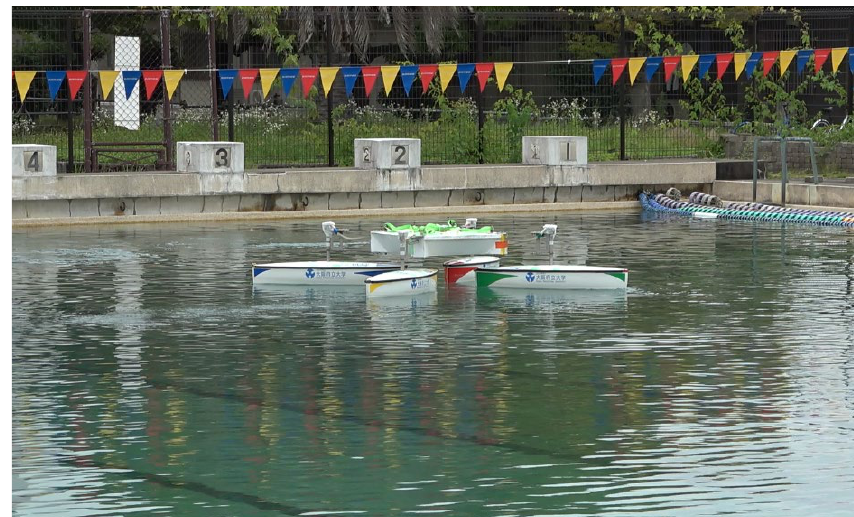
Figure 15. Running test scene in calm water.